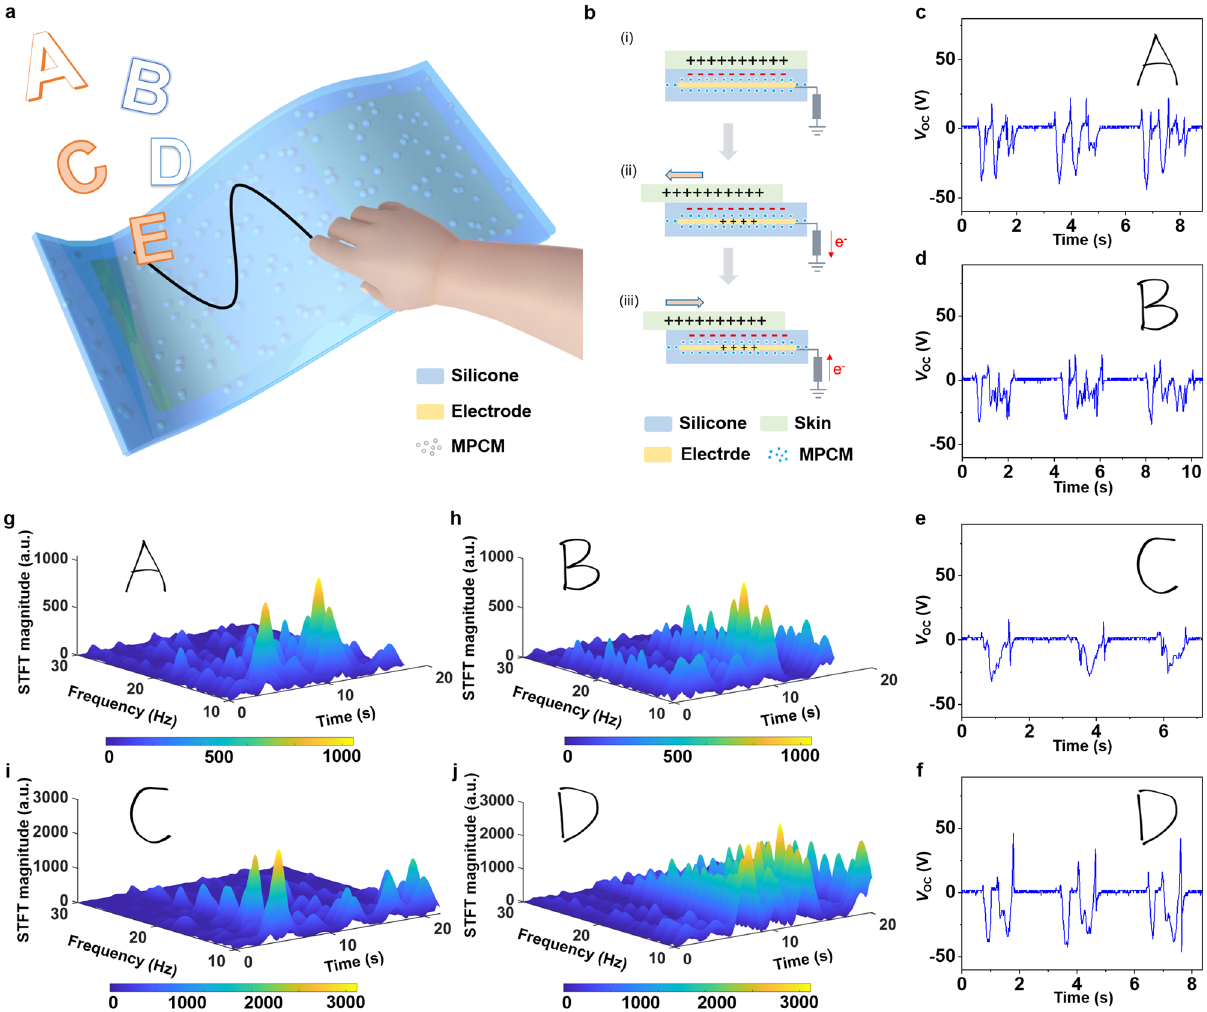
Fig. 4 A self-powered handwriting sensor based on ME-skin. a ME-skin was used as a self-powered handwriting sensor. When a fi nger wrote letters on ME-skin, the generated voltage signals were recorded by the signal acquisition device. b The working mechanism for ME-skin in a contact-sliding mode. c – f When a fi nger wrote “ A, B, C, D ” on ME-skin, the open-circuit voltage signals of ME-skin. Each letter was repeated three times. g – j Time-frequency plots of the open-circuit voltage signals of the letter “ A, B, C, D ” . Among them, the time domain of STFT was 0 – 20 s, and the frequency domain intercepted the part of 10 – 30 connected layer that outputs prediction results of eight letters. By analyzing the characteristics of the data, the visualization of the data is depicted in Fig. 5c. The result was attributed to the distribution of t-distributed Stochastic Neighbor Embedding (t- SNE) embedded in the dimensions of principal component 1 (PC1) and dimensions of principal component 2 (PC2). The voltage signals of the eight letters of “ A ” , “ B ” , “ C ” , “ D ” , “ X ” , “ J ” , “ T ” , and “ U ” were visualized respectively. This is a satisfactory clustering result, in which twenty training sets of each letter were well dispersed. 100 sets of voltage signals for each letter were collected. 80 groups were training set to train the CNN model and 20 groups were the test set to verify the accuracy of the model, as shown in Fig. 5d. Before the training process, each data was preprocessed, including 0-1 normalization and resampling. The length of each signal was scaled to interval [0,1] (0-1 normalization). Convenient for model input, the length of the signal was resampled to 1024 (resampling). By training the 1D-CNN model, the recognition rate of training reached a satisfactory 98.13%. However, not all letters have obvious characteristics. The writing